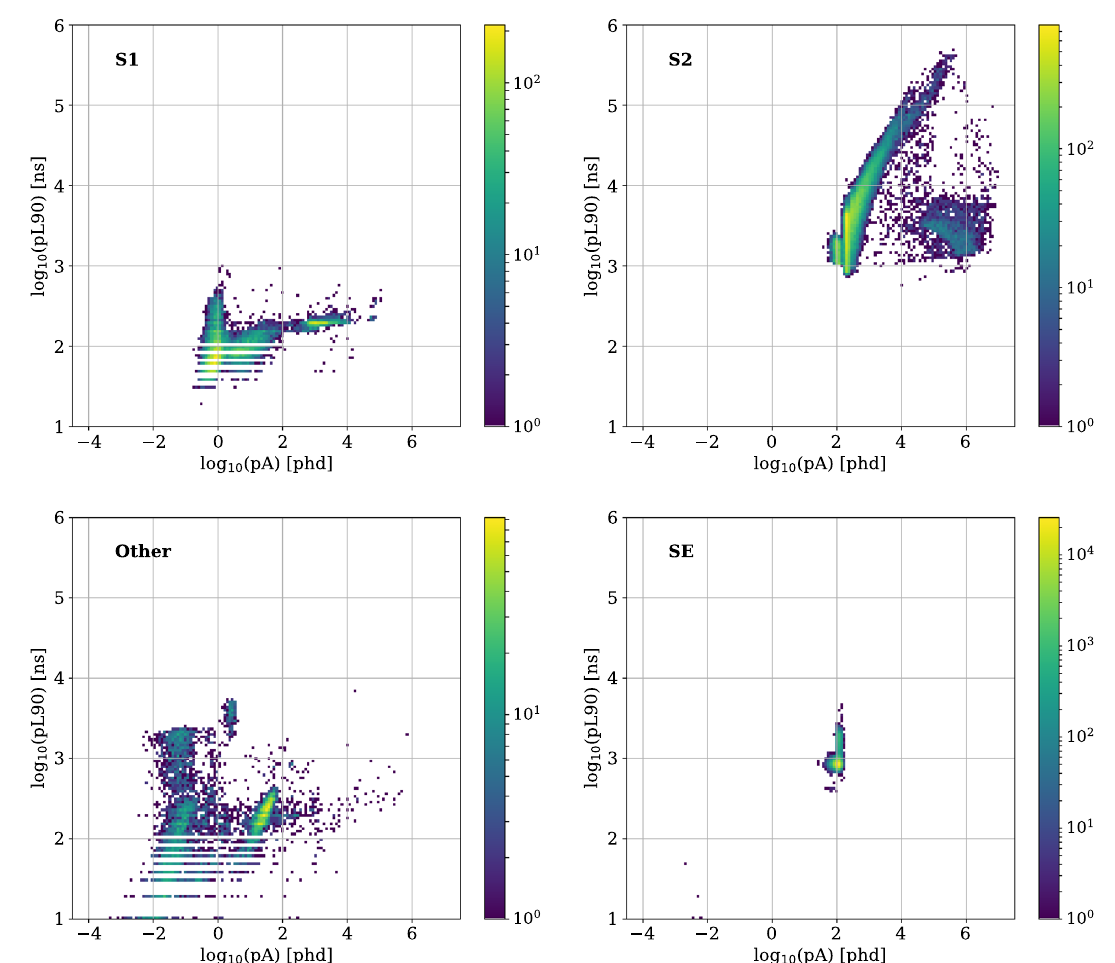
Fig. 9 Distribution of the pulse populations in the marginal distribu- tion pA vs pL90 after being processed by the TriNet Classifier trained withtheGMMresults,andconvertedtocategoricalclassifications.Top-